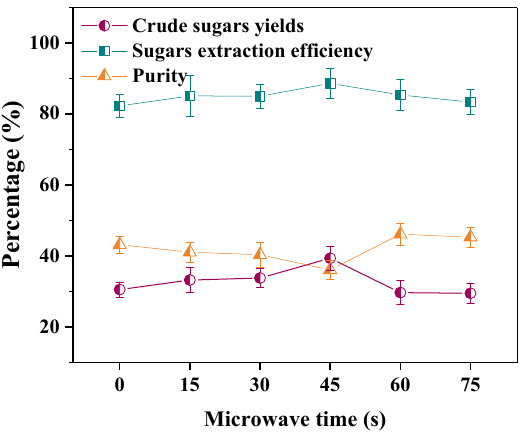
Figure 3. Effects of microwave time on crude sugar yield, purity and sugar extraction efficiency.